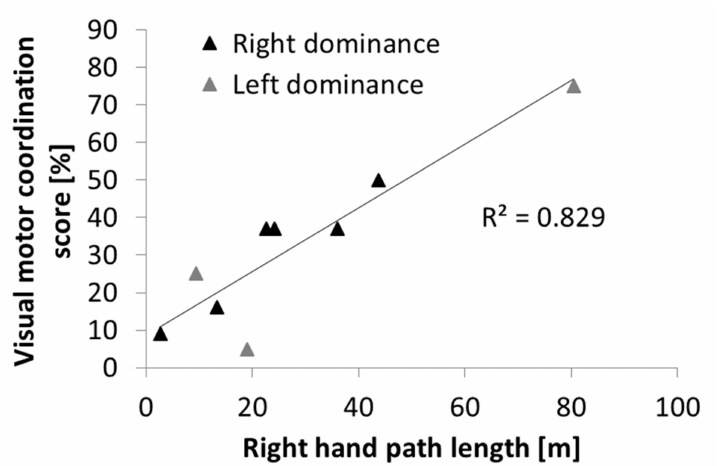
Figure 1. The visual-motor coordination Movement Assessment Battery for Children (MABC) subcategory scores as a function of the recorded right-hand path length while playing a virtual reality game for activation of the upper limbs. Data are presented for children with Developmental Coordination Disorder (DCD). Note: when removing an outlier in the right-hand path length data from this group, found using Grubb’s test, the R 2 =